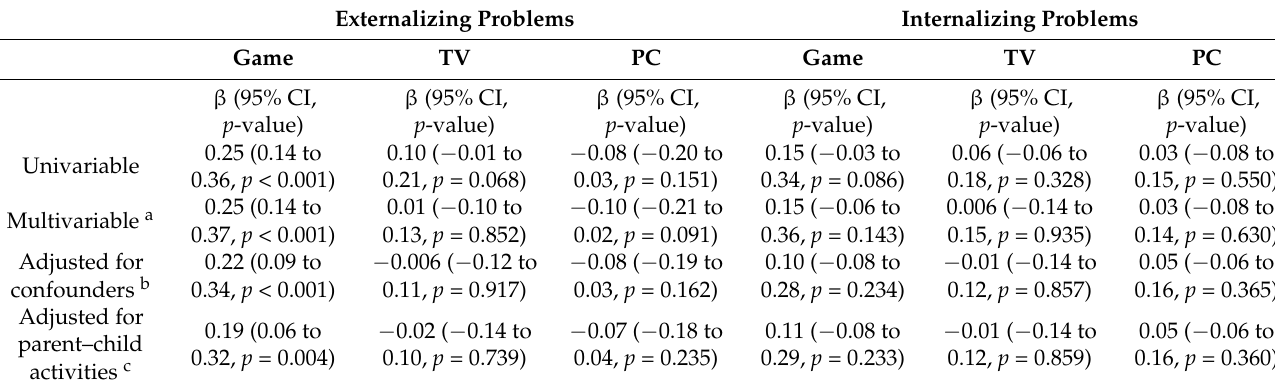
Table 3. Effect of specific screen activity type on later externalizing and internalizing